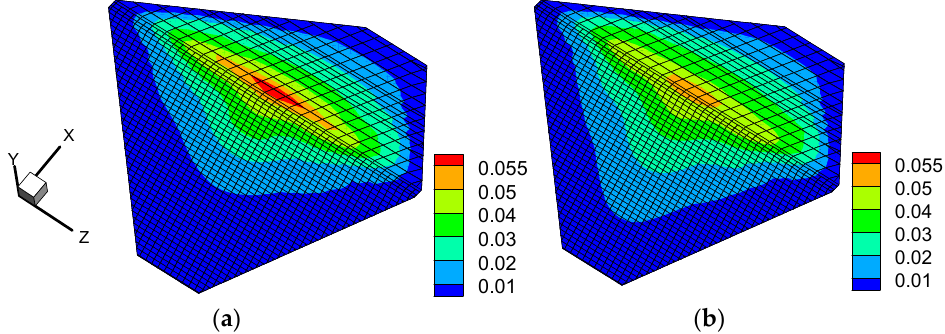
Figure 22. Maximum distribution of rockfill displacement along the vertical direction (m): ( a ) Ne- glecting hydrodynamic pressure and ( b ) the Polyhedron SBFEM.